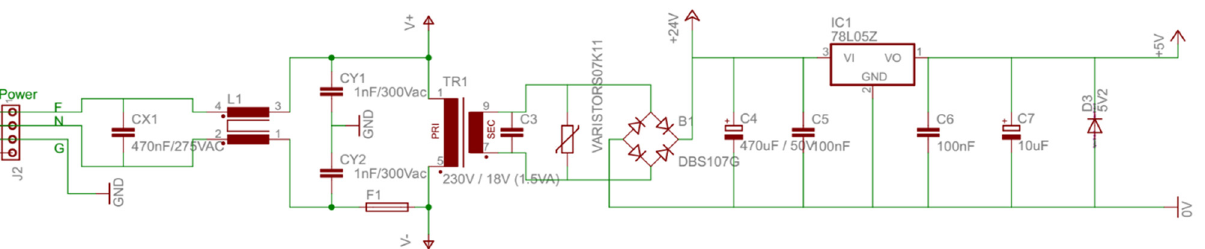
Figure 20. Electrical schematic of the AC motor power by the NC20 board, where 5 V is converted to 3.3 V by Figure 17.